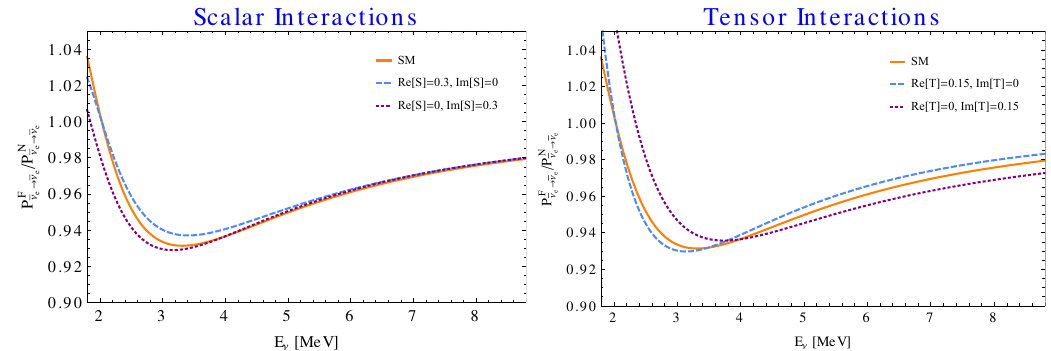
Figure 1 . The ratio of the survival probabilities at the far and near sites as a function of the neutrino energy and at distances L = 1500 m and L = 500 m. The solid orange curves are for the SM best (cid:12)t value, while the dashed blue and dotted purple curves show the NSI e(cid:11)ects. the scalar and tensor interactions compared to the SM one. Note that, as can be seen from the right panel of (cid:12)gure 1, reactor neutrino oscillations are more sensitive to tensor interactions. This is because they interfere with the SM axial interactions, which typically give larger contributions than the SM vector ones in reactor transitions and inverse beta decay. In the scalar case (the left panel) the far to near probability is similarly sensitive to the change in the real and imaginary parts. This is because the contributions of the real and imaginary parts consist of single terms (coming only from the detection side) which are of the same order and have similar e(cid:11)ects on the probability. This is not the case for the tensor case (right panel), for which the real and imaginary parts contributions appear as the sum of two terms: those two terms have opposite sign for the real part but the same sign for the imaginary part. For this reason the survival probability is more sensitive to the imaginary part of [ T ]. These comments are illustrative, as they they are valid for